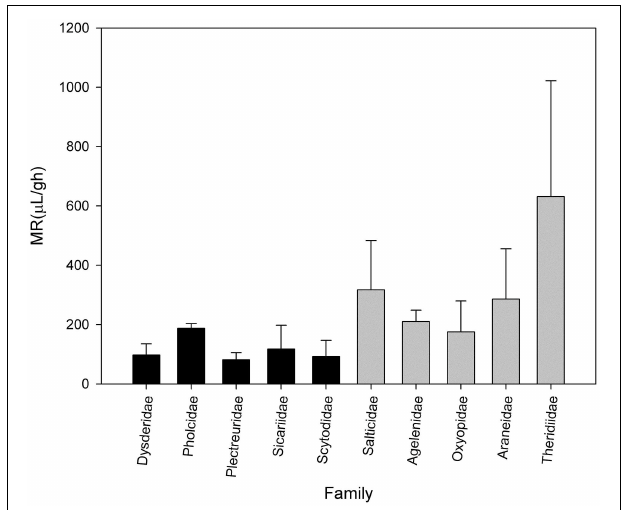
FIGURE 1 | Metabolic rate of some families of spiders of comparable body mass. Black bars represents primitive hunters and weavers haplogyne spiders. Gray bars represents modern spiders such as Salticidae and orb-weaving spiders (Data from Greenstone and Bennett, 1980; Canals et al., 2015).